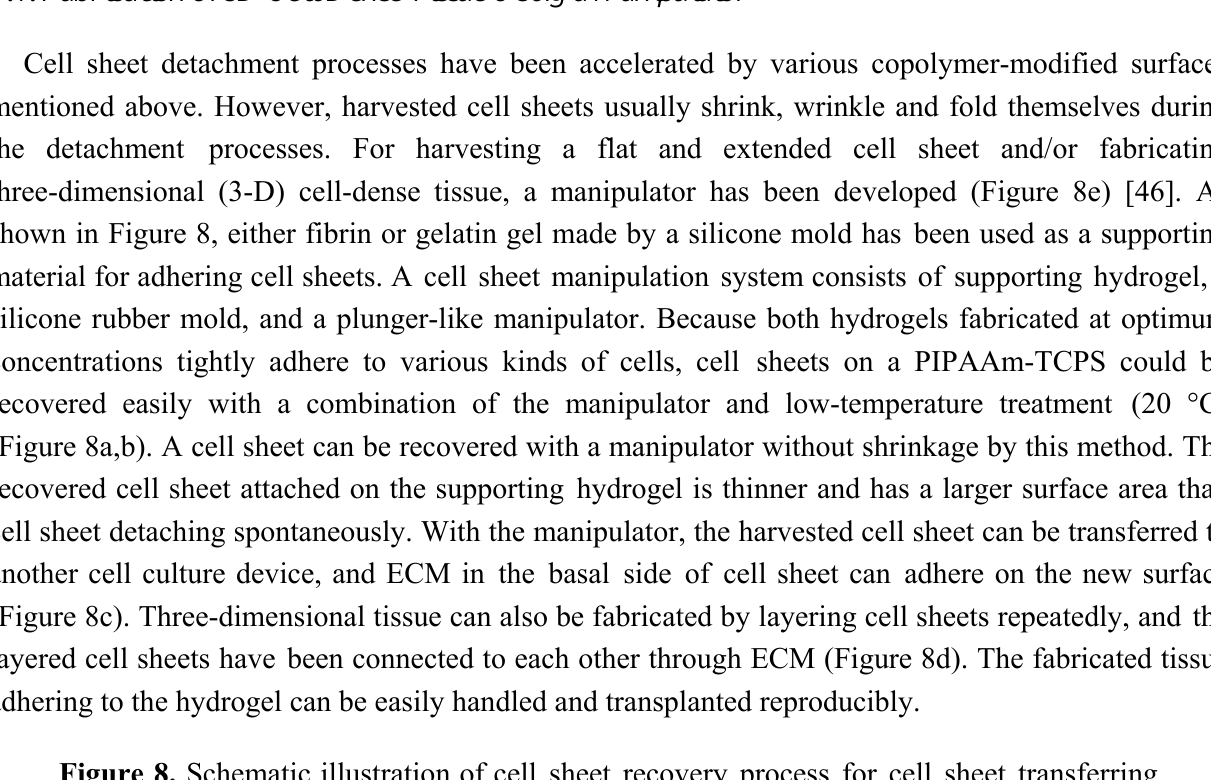
Figure 8. Schematic illustration of cell sheet recovery process for cell sheet transferring and three-dimensional tissue fabrication. ( a ) cell sheet has been covered by a hydrogel-coated manipulator and incubated at 20 °C; ( b ) cell sheet has been harvested by the manipulator; ( c ) the harvested cell sheet has been transferred to a new cell culture device; ( d ) the harvested cell sheet has been layered on another cell sheet; ( e ) macroscopic view of a cell sheet manipulation